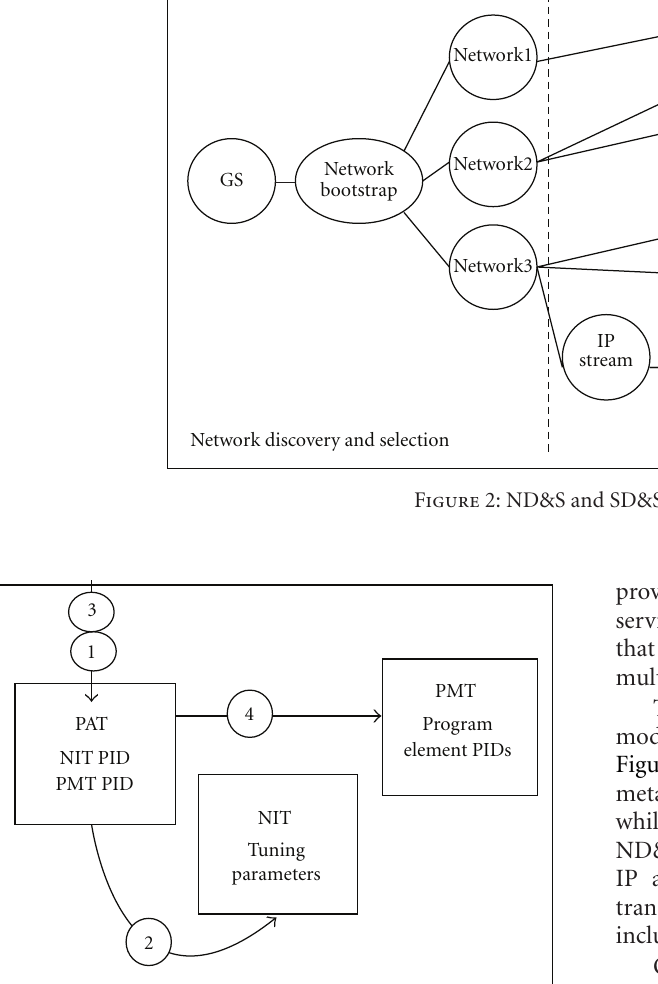
Figure 3: Initial acquisition of